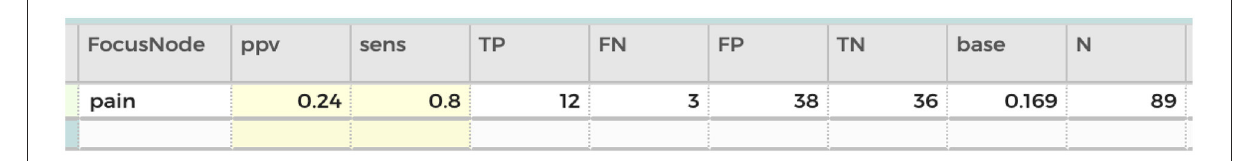
FIGURE11 Relevant measures for the feature “pain”.